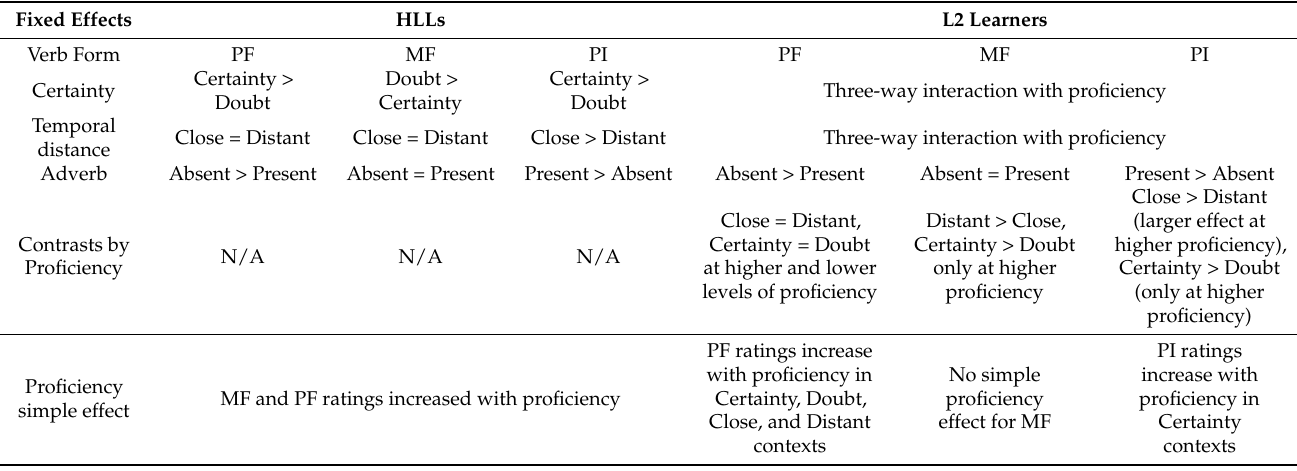
Table 3. Summary of